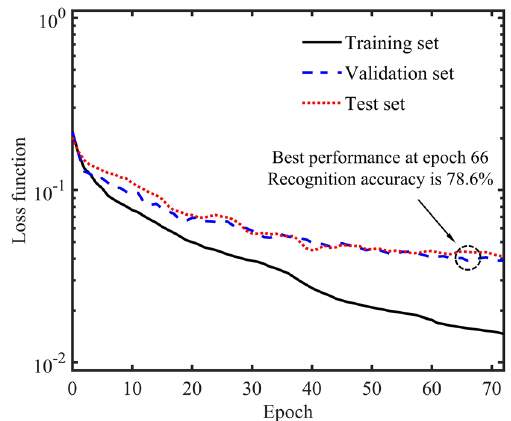
Figure 16 The loss function curve of the PRNN in the training process